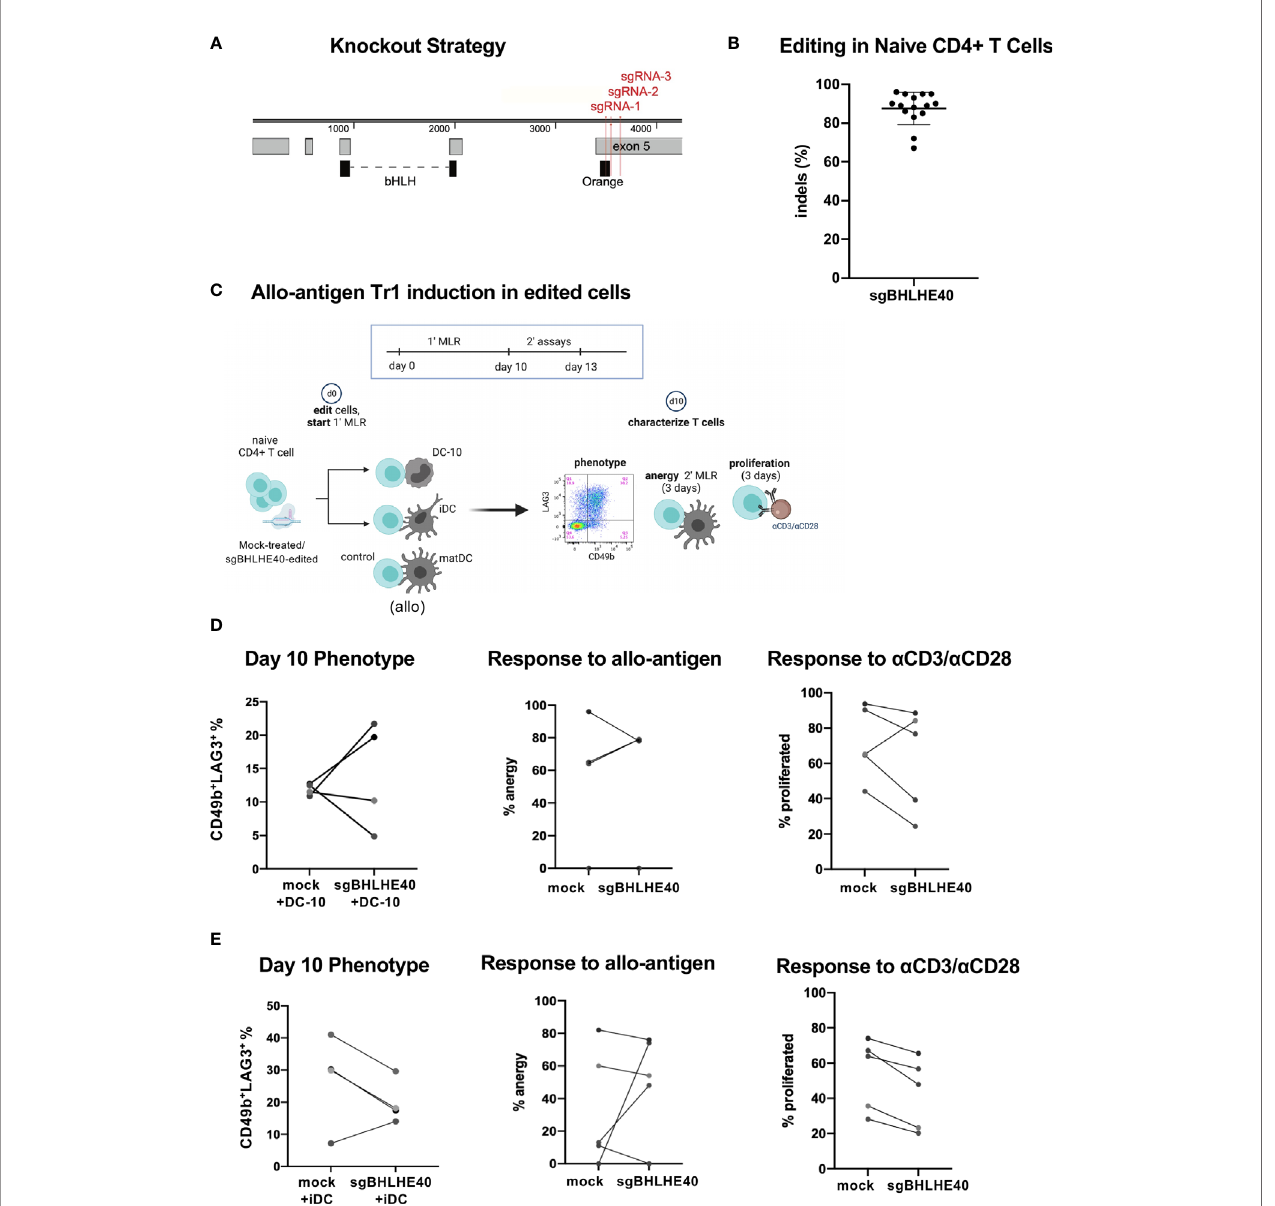
FIGURE 3 | BHLHE40 is not required for generating allo-antigen speci fi c Tr1 cells. (A) BHLHE40 knockout strategy. 3 sgRNA (red) were designed to simultaneous target the N ’ terminus exon 5 of BHLHE40. Protein domains (black) and exons (grey) are annotated. (B) High knockout ef fi ciency in naïve CD4 + T cells. Indels % were calculated 2-3 days after nucleofection. N = 15 healthy donors. (C) Schematic of allo-antigen Tr1 cell induction of sgBHLHE40-edited cells with iDC, DC-10, or control matDC. (D, E) CD4 + T cell characterization after primary MLR with (D) DC-10 or (E) iDC. %Tr1 cells 10 days after primary MLR. Tr1% is measured by fl ow cytometry and gated on live/CD3 + /CD4 + /CD45RA - /CD49b + /LAG3 + cells (left). Allo-antigen speci fi c anergy assay of cells restimulated in a secondary MLR with matDC. % anergy of mock-treated and sgBHLHE40-edited (middle). Proliferation response, as indicated by CFSE dye dilution, of mock-treated and sgBHLHE40- edited cells taken at day 10 of the primary MLR after restimulation with Dynabeads for 3 days (right). n = 5 healthy